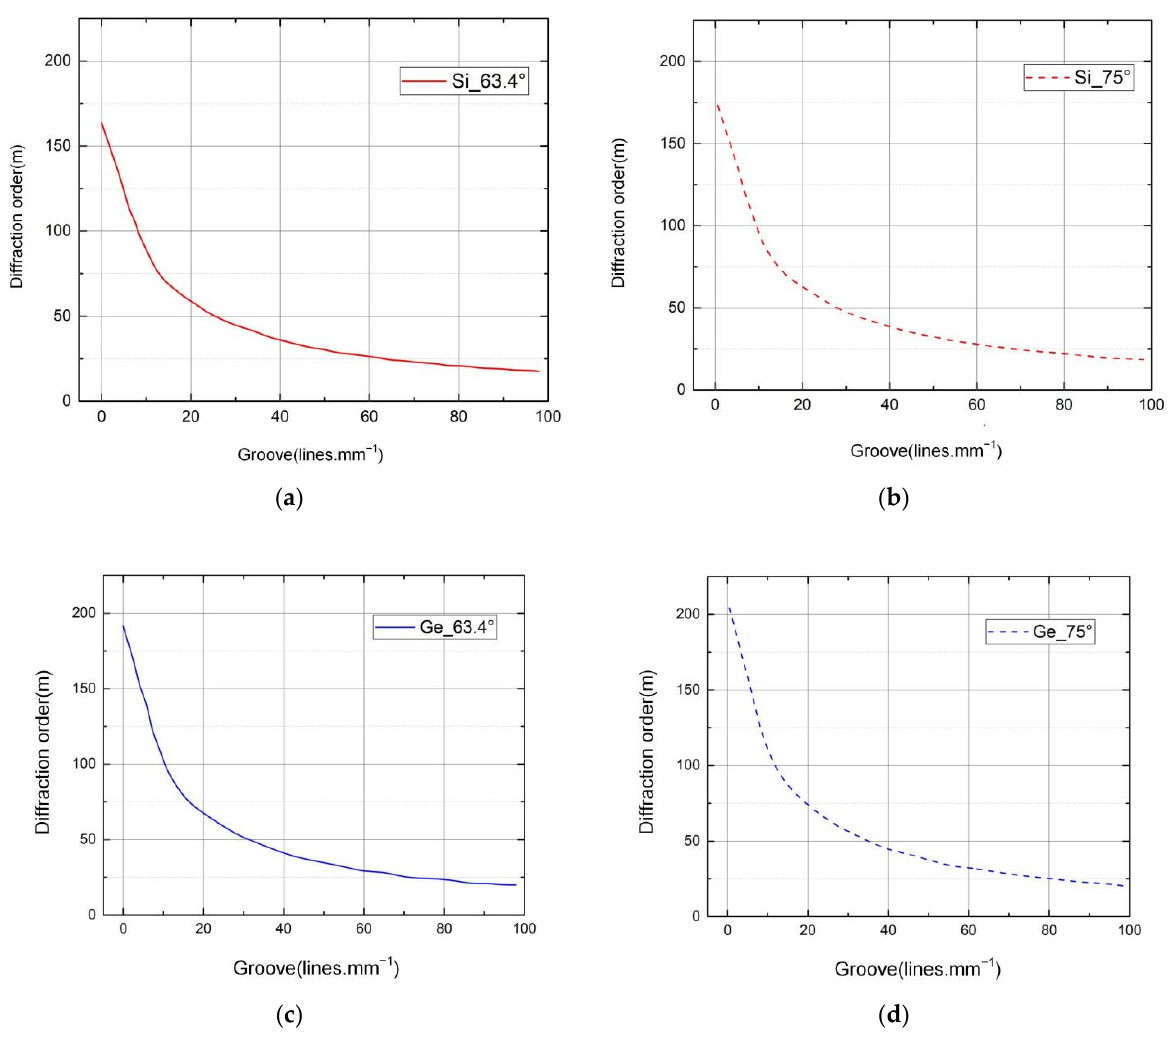
Figure 11. Relationships between grating line density and diffraction order for different immersion materials and blaze angles: ( a )silicon immersion grating, blaze angle 63.4°; ( b ) silicon immersion grating, blaze angle 75°; ( c ) germanium immersion grating, blaze angle 63.4°; ( d ) germanium immersion grating, blaze angle 75°.